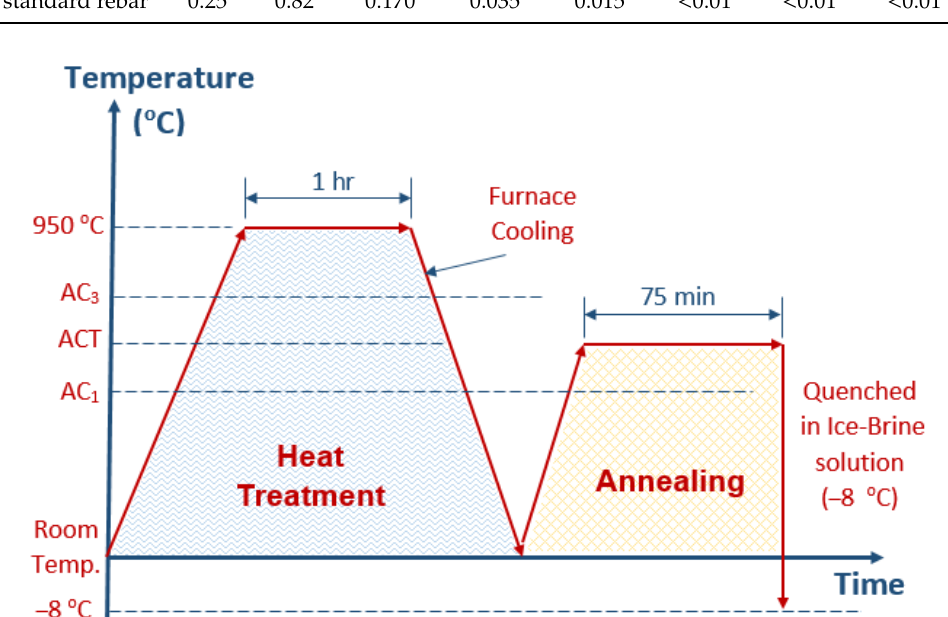
Figure 1. Schematic of the total heat-treatment process. Table 1. Chemical composition of the studied steels (wt %).